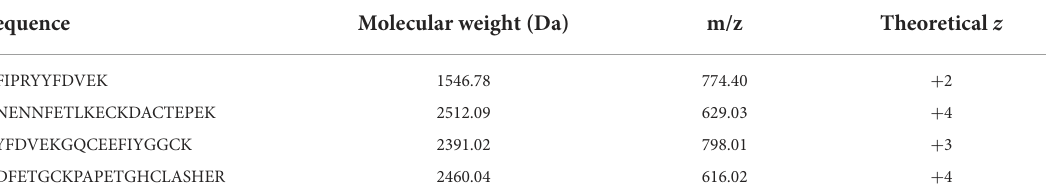
TABLE 2 Mass spectrometry identification of rDoenitin-1.